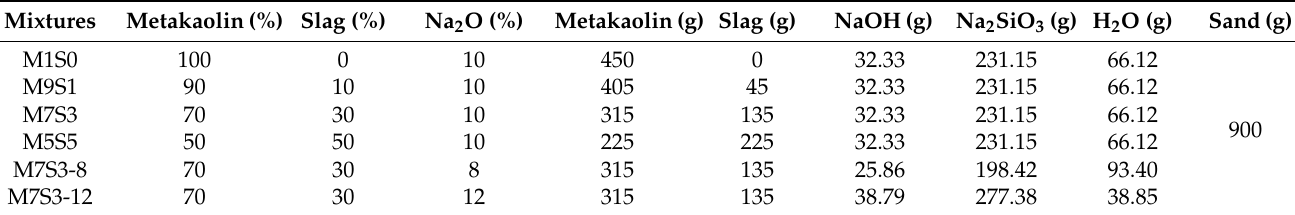
Table 2. Proportions of AAMS composite cementitious